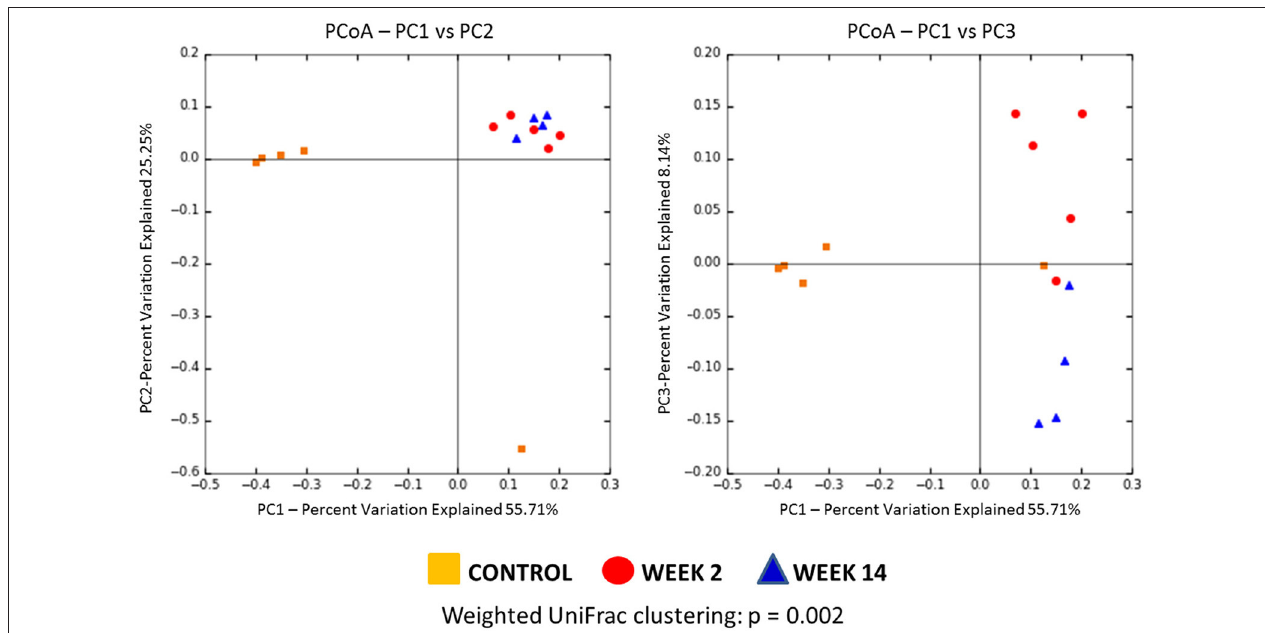
FIGURE 6 | Principal coordinate analysis (PCoA) plot of the microbiome from three groups (Control, Week 2, and Week 14) using weighted UniFrac clustering (Control = Orange, Week 2 = Red, Week 14 = Blue). Using weighted UniFrac clustering, significant differences in beta diversity were found among three groups ( p = 0.002).